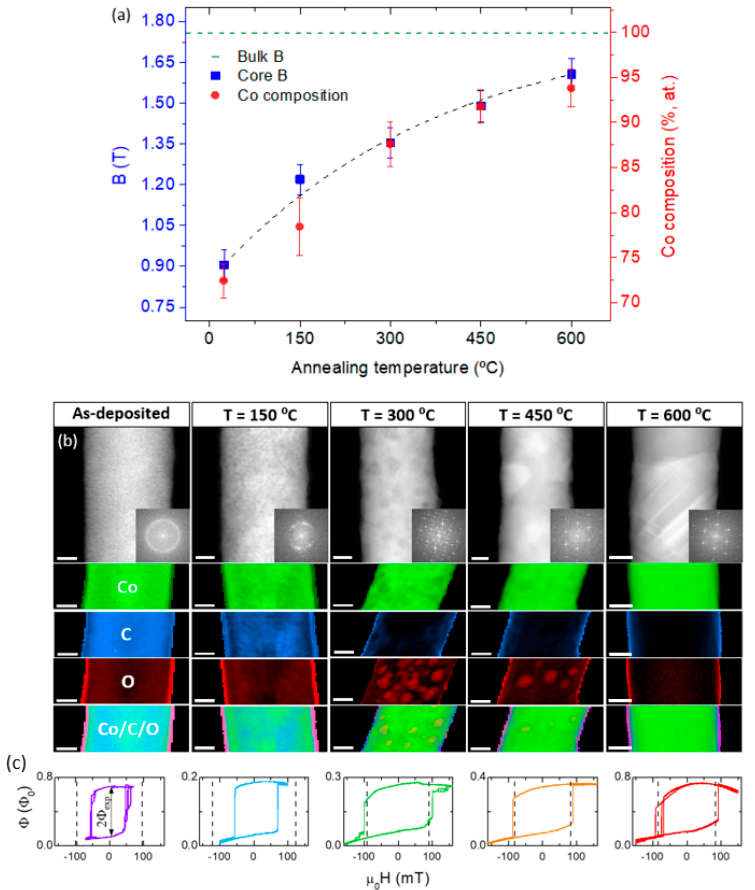
Figure 4. Scanning transmission electron microscopy characterization of Co nanowires under an annealing post-growth purification process. ( a ) Average B-field and Co composition as a function of annealing temperature measured by off-axis electron holography. ( b ) High-angle annular dark-field and corresponding fast-Fourier-transform (first row), and chemical maps by electron energy loss spectroscopy (following rows). Scale bars are 20 nm . ( c ) Hysteresis loops obtained by nano-SQUID (super quantum interference device) magnetometry at 15 K for each of the wires. ( a , b ) Reproduced with permission from [52]. ( c ) Reproduced with permission from [55]. Copyright 2018 American Chemical Society.